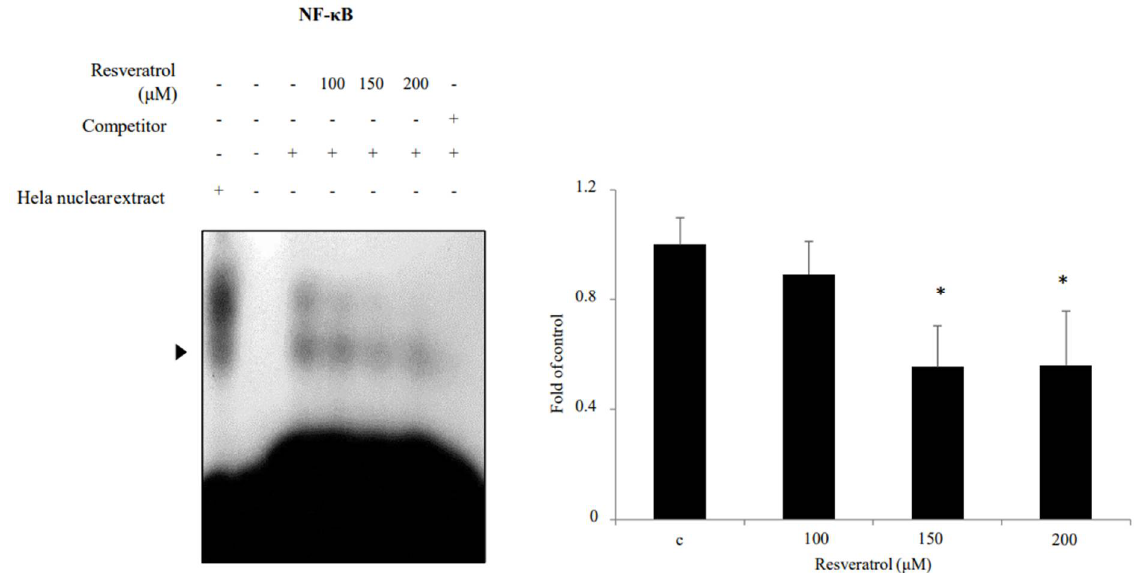
Figure 7. Inhibition of NF- κ B binding activity in WPMY-1 cells by resveratrol treatment. WPMY-1 cells were treated with various resveratrol concentrations (0, 100, 150, and 200 µ M). Nuclear extracts were collected from the WPMY-1 cells and the binding activity of the NF κ B was measured using the EMSA analysis. The data are expressed as mean ± SD as a result of three independent experiments depending on the resveratrol concentration (* p < 0.05).